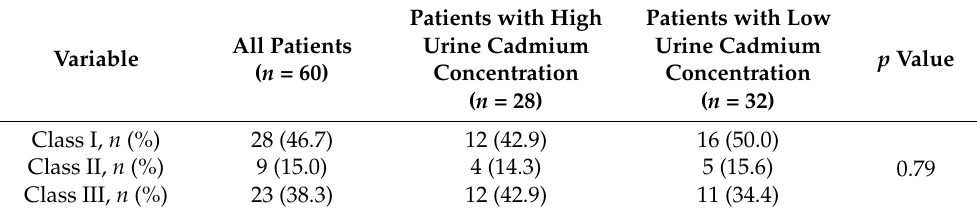
Table 3. Malocclusion type based on molar relationships of orthodontic patients (Angle’s classifica- tion), stratified according to their urine cadmium concentrations as high or low ( n = 60).